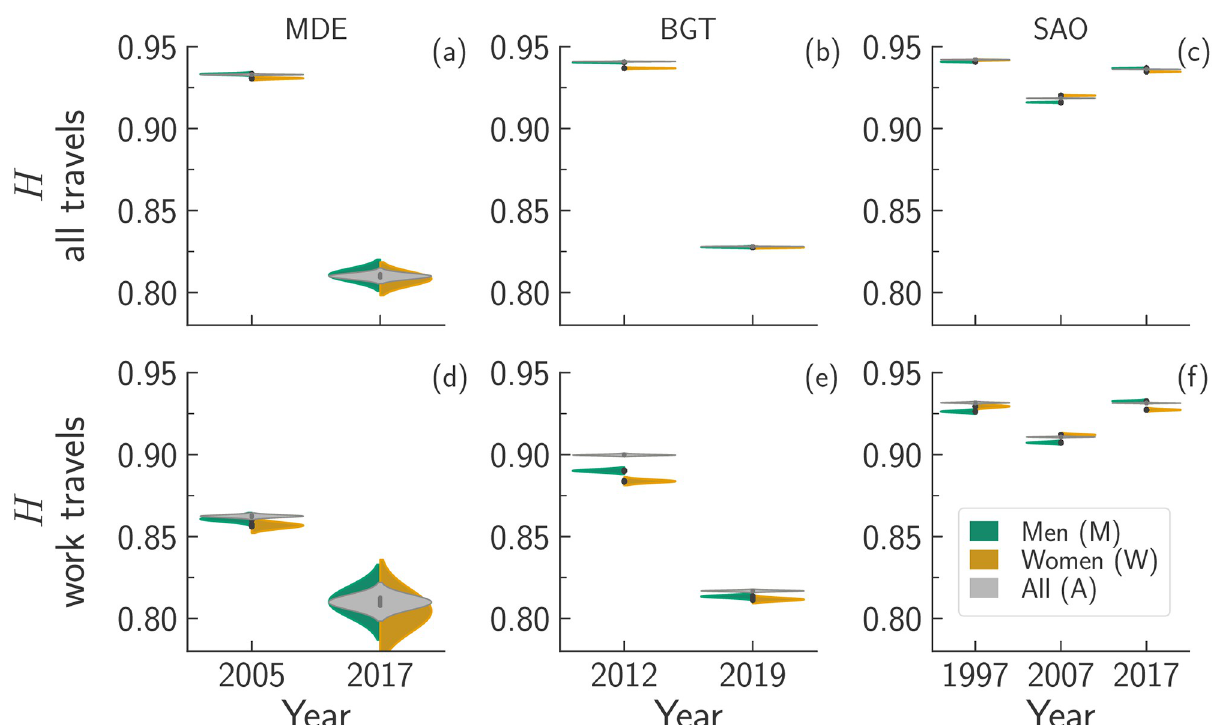
Fig 5. Violin plots of the bootstrapped mobility diversity, H , for all travels (top row, panels a-c), and work travels (bottom row, panels d-f). Each column refers to a different region: MDE (panels a and d), BGT (panels b and e), and SAO (panels c and f). For each region, we display the distribution of the values of H in each year. We show the distributions for all travels duplicated (entire violins), and the distributions for men and women travels in half-violins.